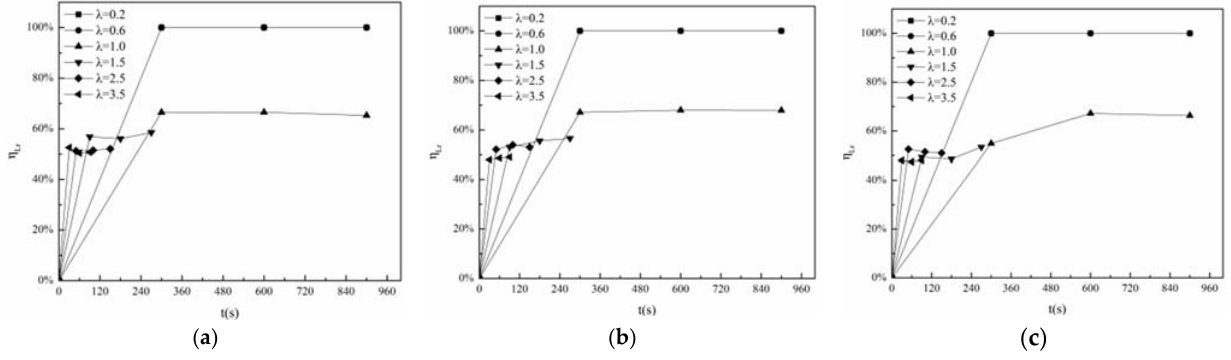
Figure 14. Right icing limit: ( a ) d = 20 mm; ( b ) d = 30 mm; ( c ) d = 40 mm.